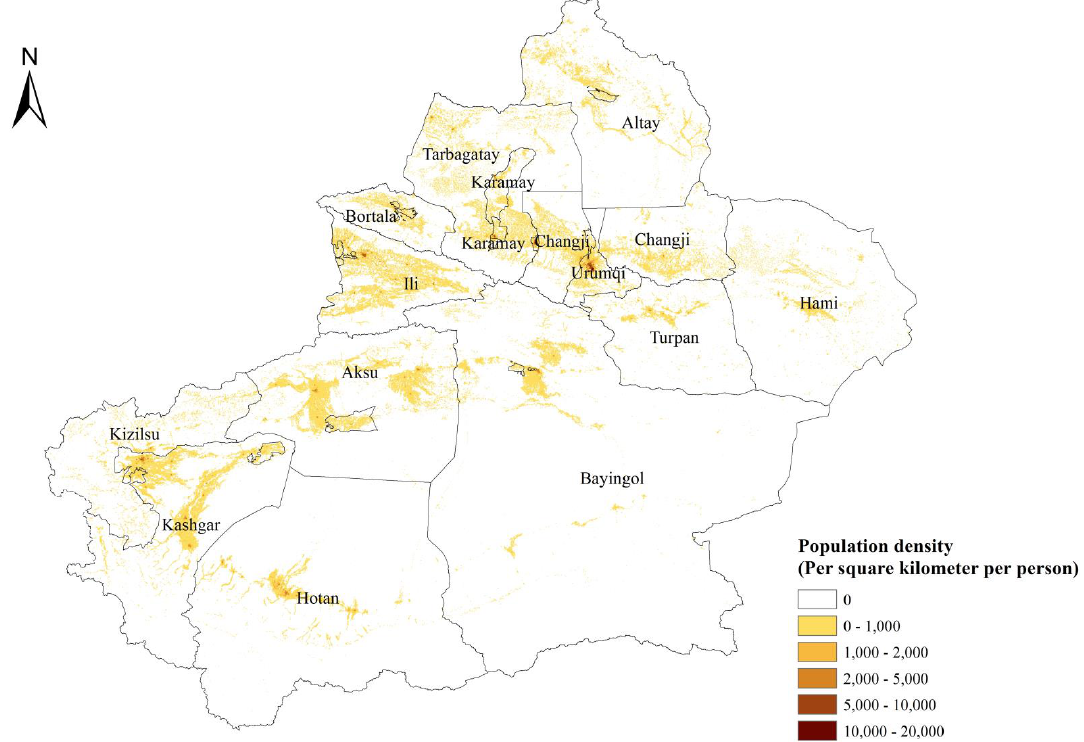
Figure A3. Spatial distributions of population.